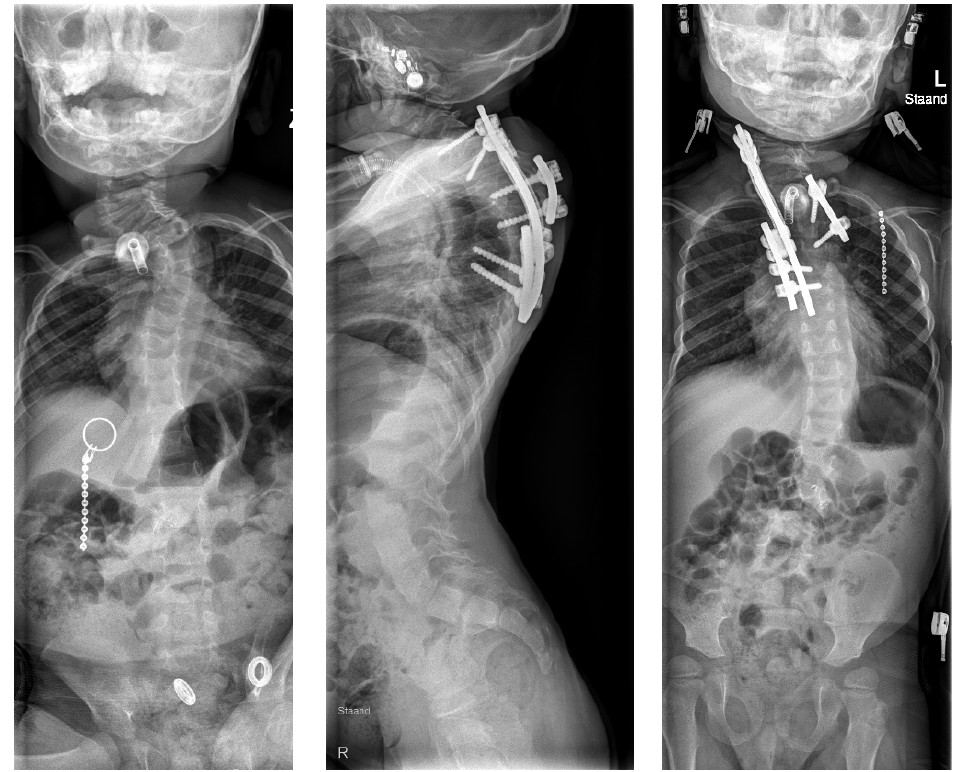
Figure 7. Case 2: preoperative AP sitting radiograph ( left ) and postoperative lateral ( middle ) and AP ( right ) standing radiographs.